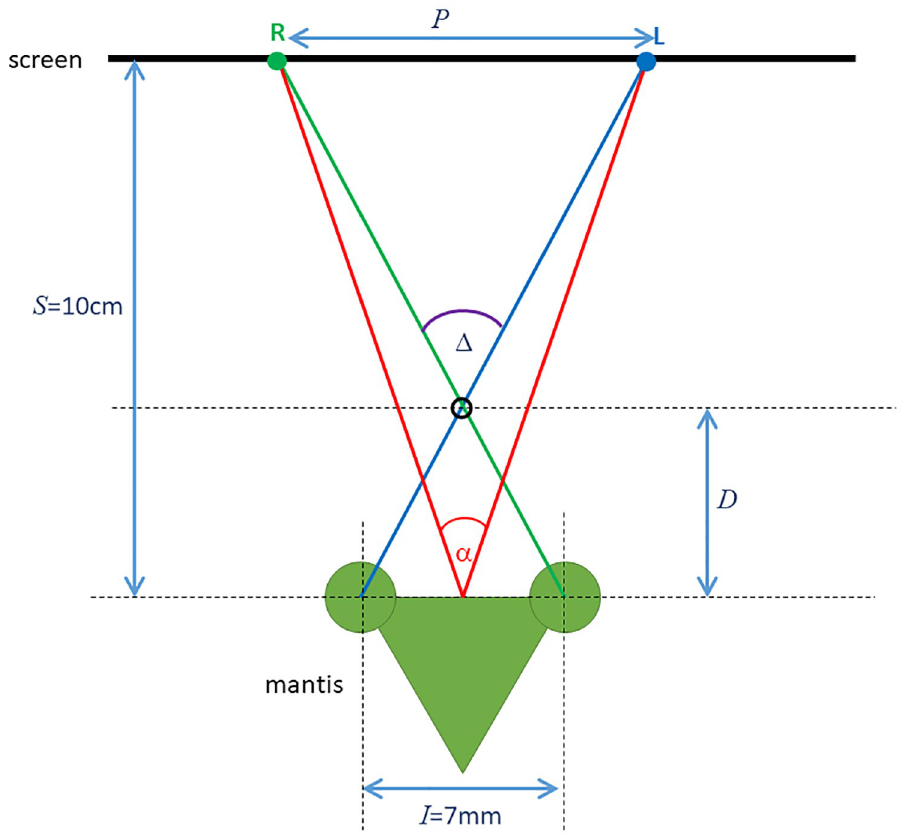
Fig 8. Top-down view (not to scale) of a mantis viewing a computer screen at a distance S . To simulate an object at distance D from the mantis, the left and right eye’s images (labelled L, R) need to be separated by a distance P on the screen. The angle subtended by the distance P at the mantis is the screen disparity α ; the retinal disparity Δ of the virtual object is the angle subtended by the interocular distance I at the virtual